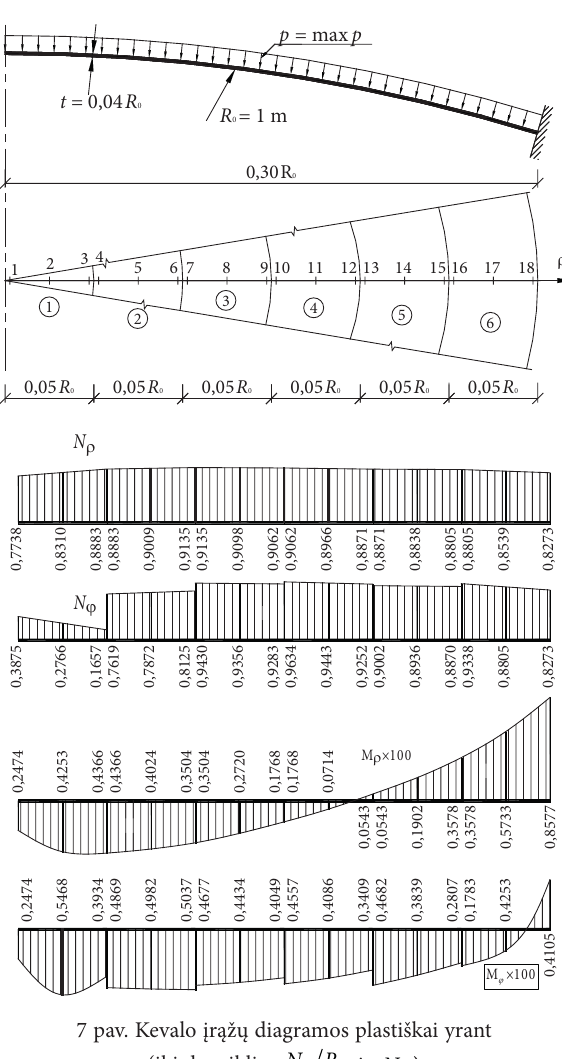
Fig. 6. A computational scheme of an elastic-plastic spherical